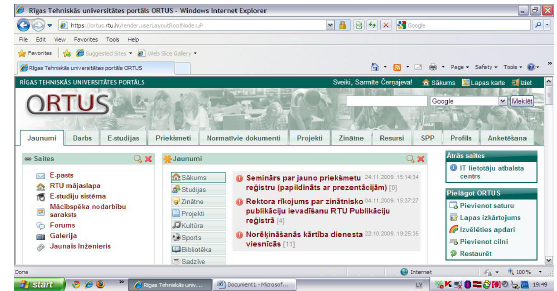
Figure 7. Riga Technical University ORTUS website